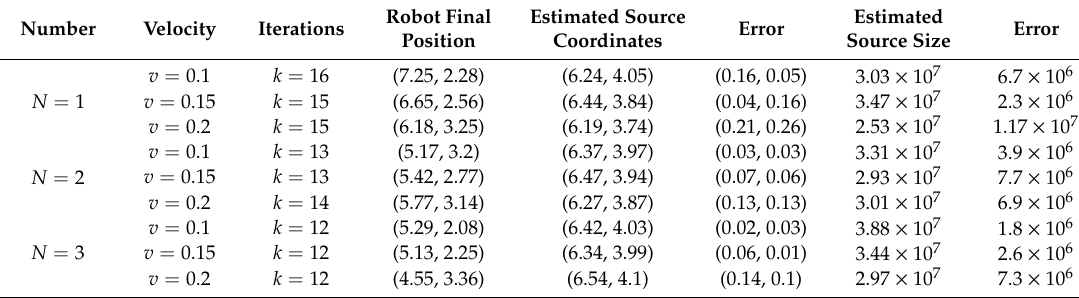
Supplementary Materials: The following are available online at http: // www.mdpi.com / 1424-8220 / 20 / 12 / 3461 / s1. Figure S1: The estimation results of radioactive sources when the number of measurements N = 5 and angular velocity ω = 0.1 rad/s. Figure S2: The estimation results of radioactive sources when the number of measurements N = 10 and angular velocity ω = 0.1 rad/s. Figure S3: The estimation results of radioactive sources when the number of measurements N = 15 and angular velocity ω = 0.1 rad/s. Figure S4: The estimation results of radioactive sources when the number of measurements N = 20 and angular velocity ω = 0.1 rad/s. Figure S5: The estimation results of radioactive sources when the number of measurements N = 20 and angular velocity ω = 0.3 rad/s. Figure S6: The estimation results of radioactive sources when the number of measurements N = 20 and angular velocity ω = 0.5 rad/s. Figure S7: The estimation results of radioactive sources when the number of measurements N = 20 and angular velocity ω = 0.9 rad/s. Figure S8: Real experiment